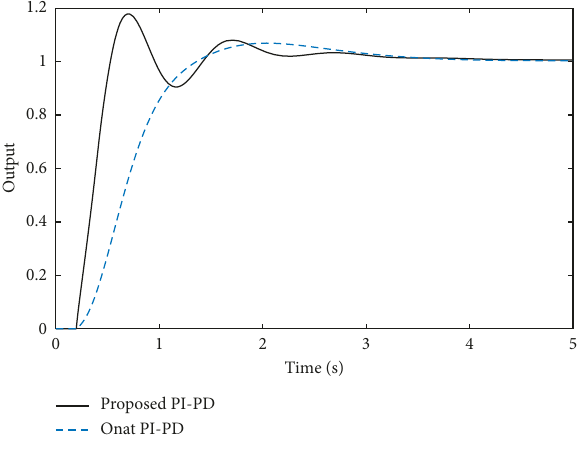
Figure 17: Step responses in example